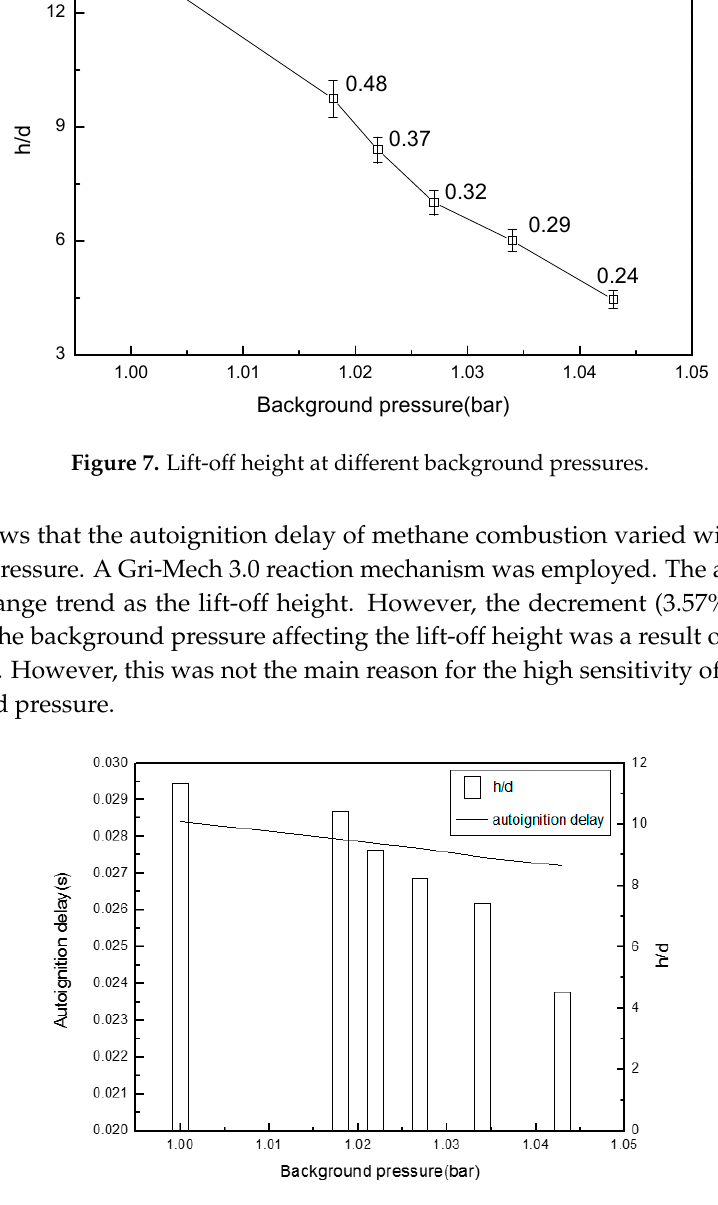
Figure 8. Calculated autoignition delay time vs. background pressure.